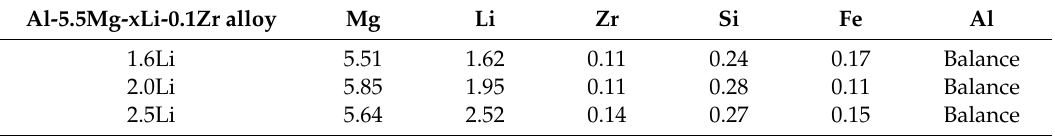
Table 1. Measured chemical compositions of Al-5.5Mg-xLi-0.1Zr (in wt%)